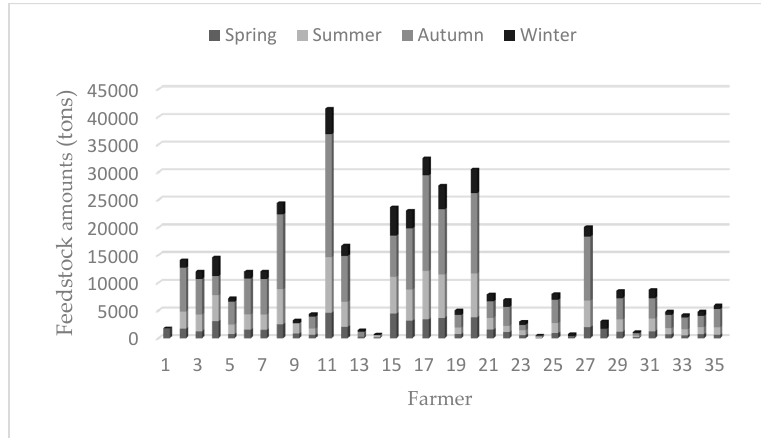
Figure 7. Feedstock amount from farmers.